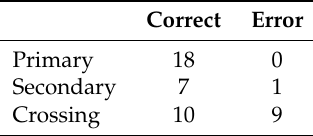
Table 2. Sag model recovery performance on the Gilberthorpes dataset.